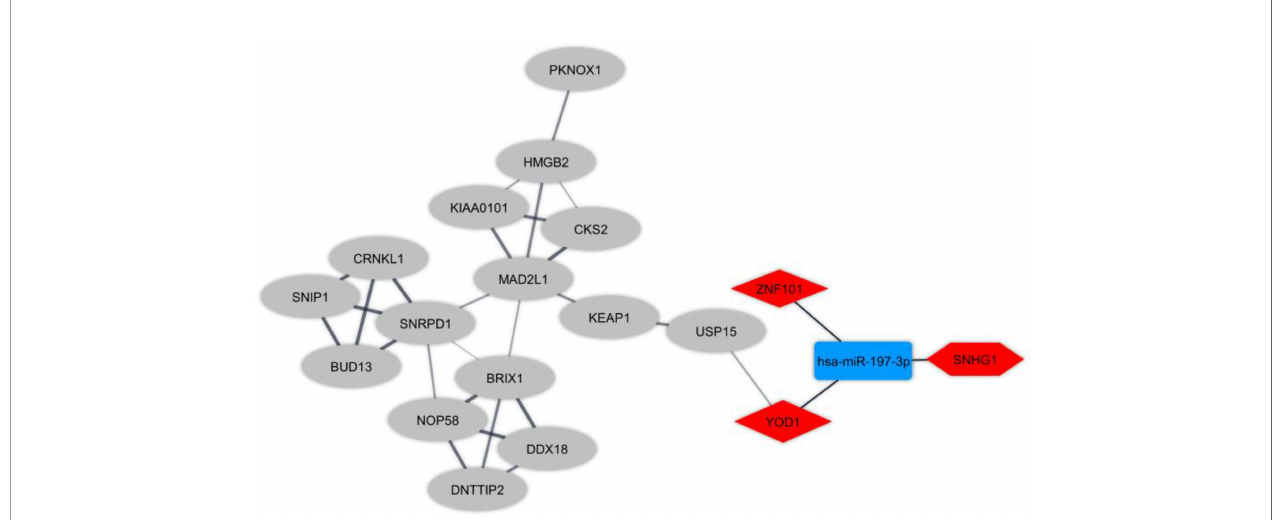
FIGURE 3 | The long non-coding RNA-associated competing endogenous RNA (ceRNA) axes in T-cell in Multiple sclerosis. The red and blue nodes represent the upregulation and downregulation, respectively. The hexagon nodes and the round rectangle nodes represent the lncRNA and miRNA, respectively. The diamond nodes represent miRNAs targeted mRNAs. The ellipse nodes represent downstream connected